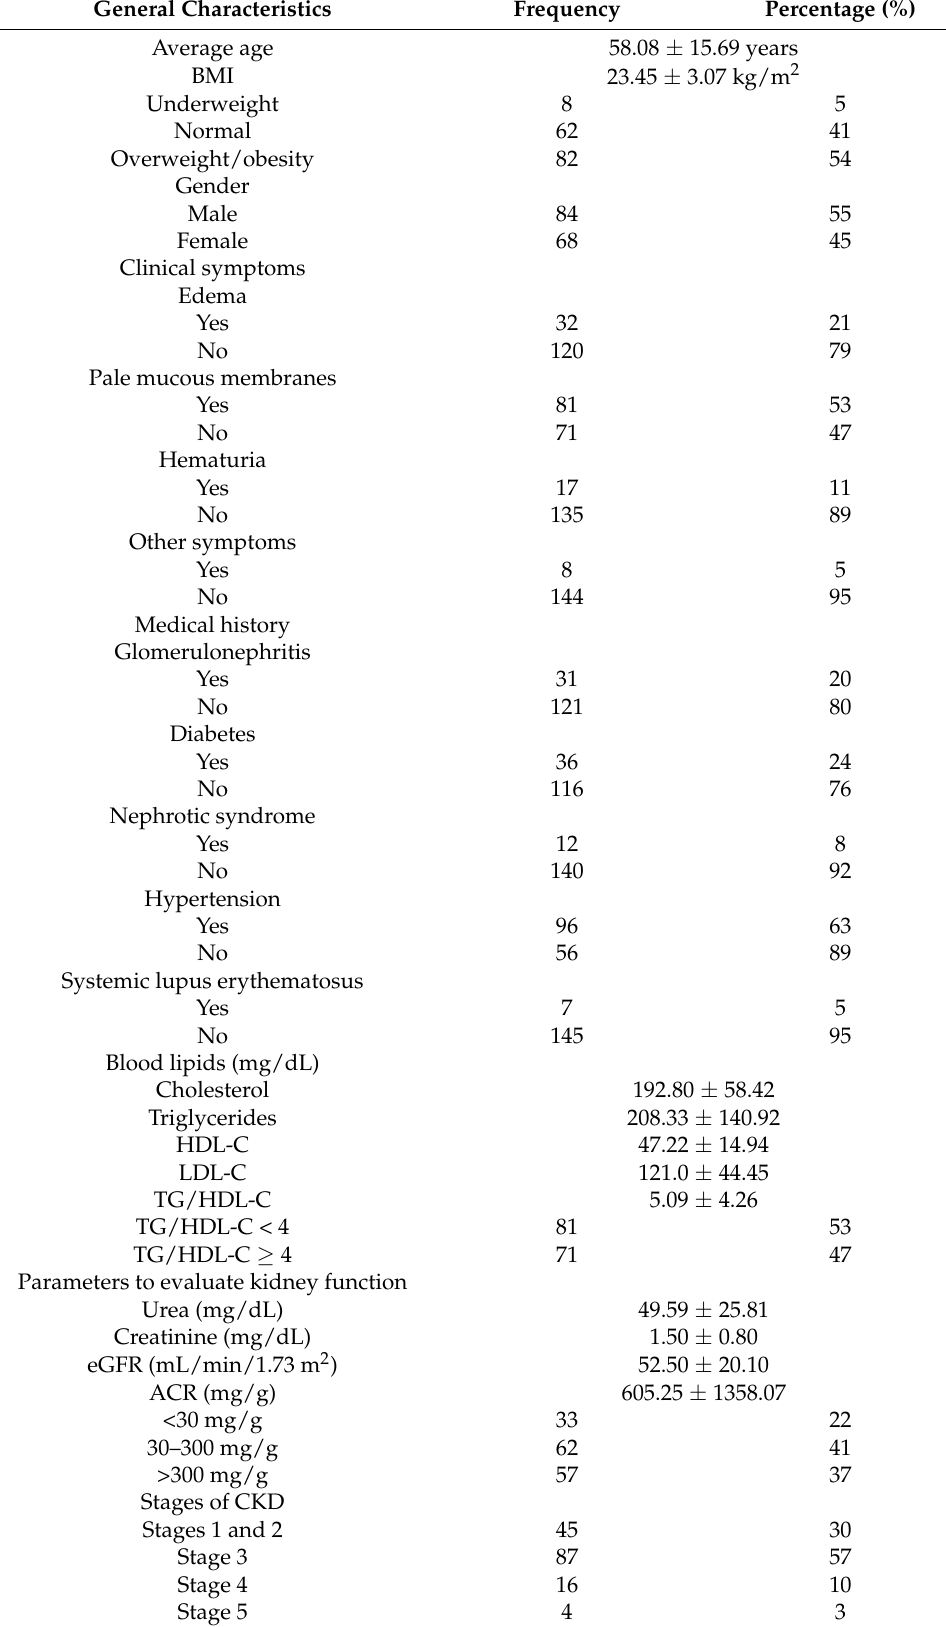
Table 2. Patient